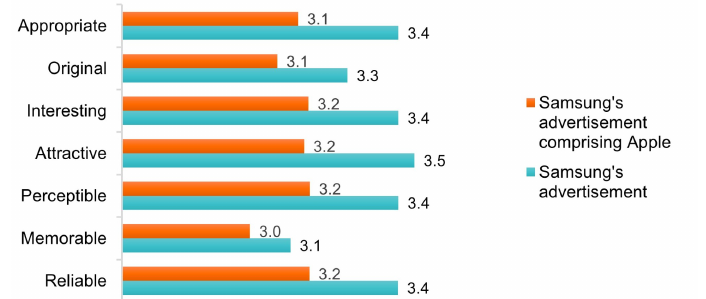
Figure 1. Results about advertising made by Samsung only with branded products and about advertising made by Samsung when it includes Apple